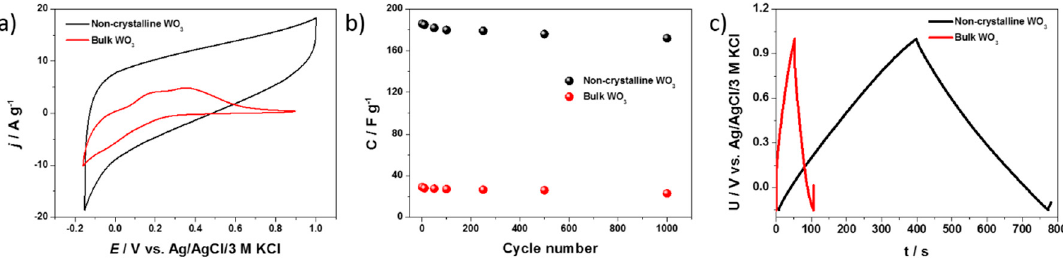
Figure 7. ( a ) Cyclic voltammograms for the non-crystalline and bulk WO 3 . ( b ) Curves of specific capacitance vs. cycle number for hydrated and bulk WO 3 . ( c ) Exemplary galvanostatic charge–discharge curves of electrodes at 0.2 A g − 1 (in a three-electrode configuration).